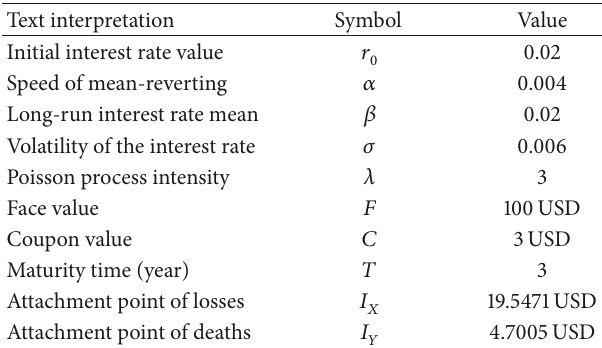
Table 2: Parameter estimates of Copula function and K-S test results.